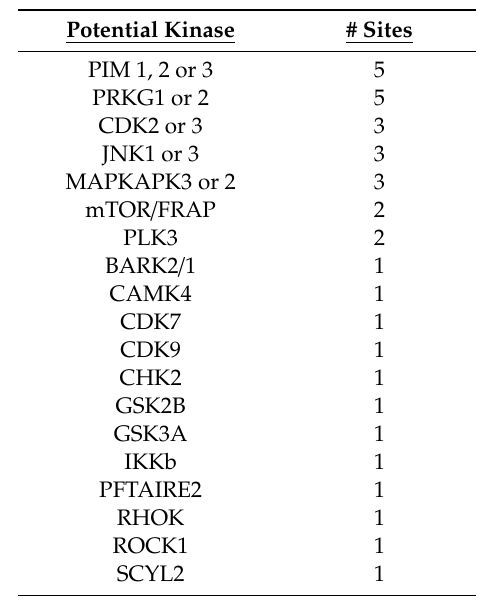
Table 3. Kinases potentially inhibited by analog